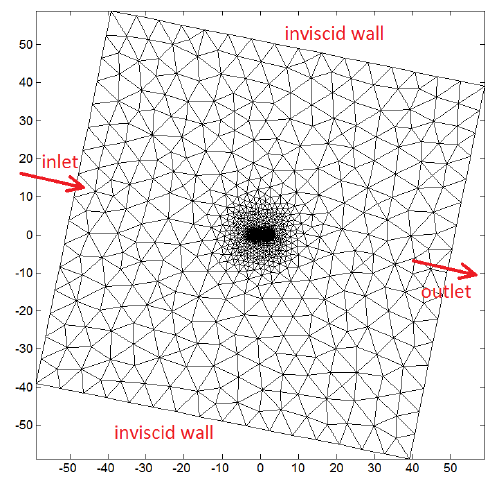
Fig. 2. Computational domain and triangular mesh.